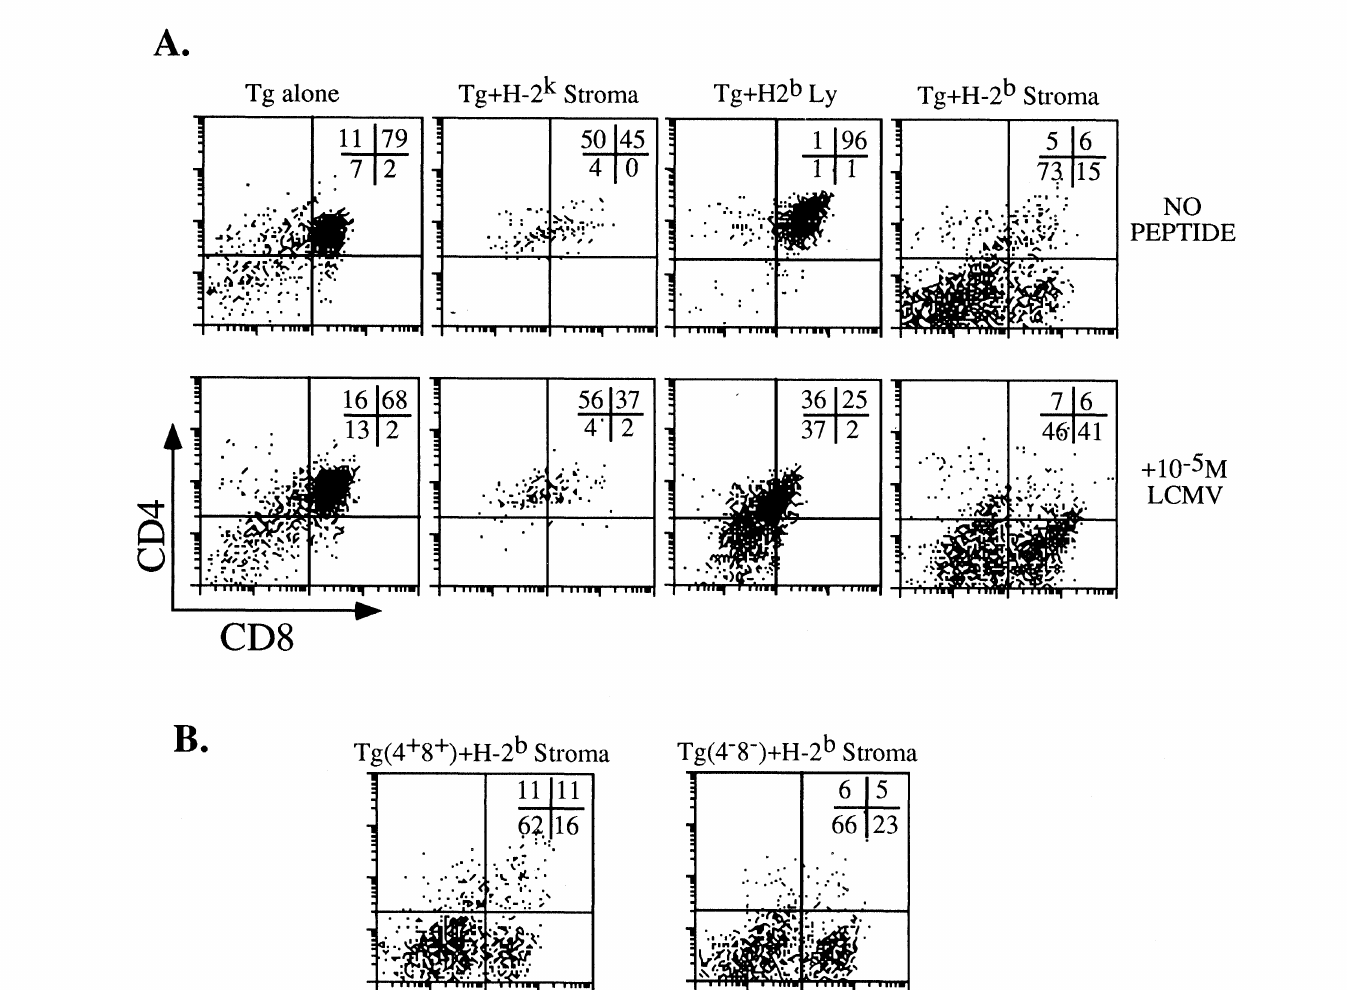
FIGURE 2 CD4-CD8 cells develop when CD4+CD8 P14 transgenic thymocytes are cultured in cell suspension with selecting MHC stroma but not with nonselecting MHC stroma. (A) To show that CD8 cells were not preselected, day-17 embryonic (El7) P14 transgenic thymocytes (H-2Db-restricted, on a H-2 background) were cultured alone or in the presence of nonselecting (H-2 k) stroma. To illustrate the importance of selecting stroma in positive selection, El7 transgenic cells were co-cultured with H-2 lymphocytes, H-2b-expressing fibroblasts (MC57), or selecting stroma (H-2b; Ly 5.1 C57B 16). These co-cultures were set up in the absence (top panel) and presence (bottom panel) of the nominal LCMV peptide (amino acids 33-41; KAVYNFATM) at a concentration of 10 -5 M as described in Materials and Methods. After 5 days, cells were counted and analyzed by FACS. Transgenic cells were distinguished from stromal-related lymphocytes by Ly 5.2 or H-2 expression, then analyzed for CD4 and CD8 expression. Typical CD4 vs. CD8 profiles of transgenic cells are shown. (B) El7 transgenic cells were presorted for CD4+CD8 thymocytes to eliminate the possibility that immature CD8 intermediate cells at El7 were merely expanding in culture. These CD4+CD8 cells were cocultured with H-2 stroma in the absence of peptide as described and harvested on day 5. CD4 vs. CD8 profiles of recovered transgenic cells are shown. To illustrate that these cocultures can also support the differentiation of double-negative cells, CD4-CD8- cells were cocultured with H-2 stroma and harvested on day 5. CD4 vs. CD8 profiles of recovered transgenic cells are